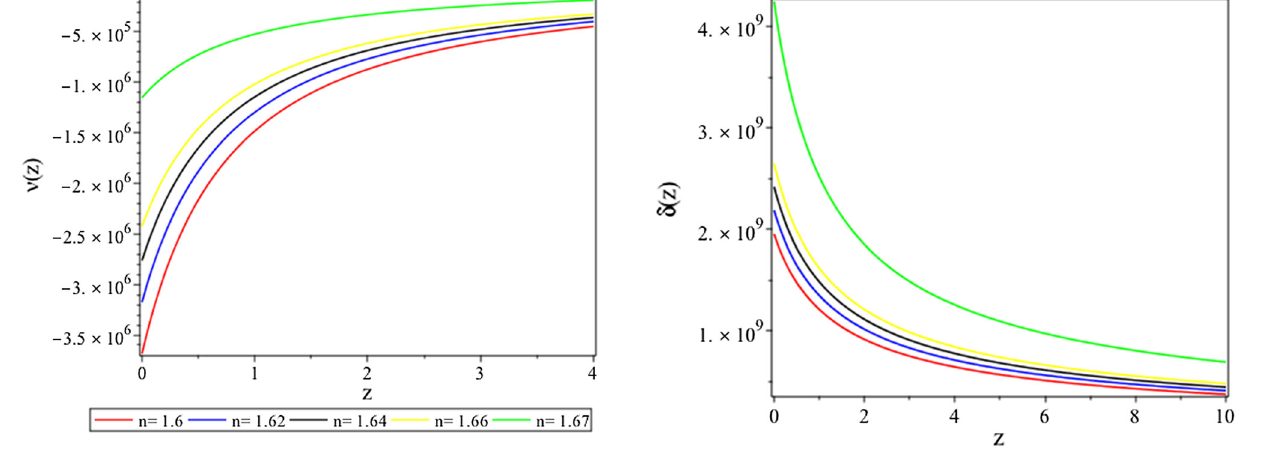
Fig. 5 The growth of velocity contrast versus cosmological redshift Eq. (146) for the power law f ( T ) gravity model for quasi-static approx- imations for n > 1 . 5 Fig. 6 The growth of density contrast versus cosmological redshift Eq. (147) for the power law f ( T ) gravity model for quasi-static approx- imations for n > 1 . 5